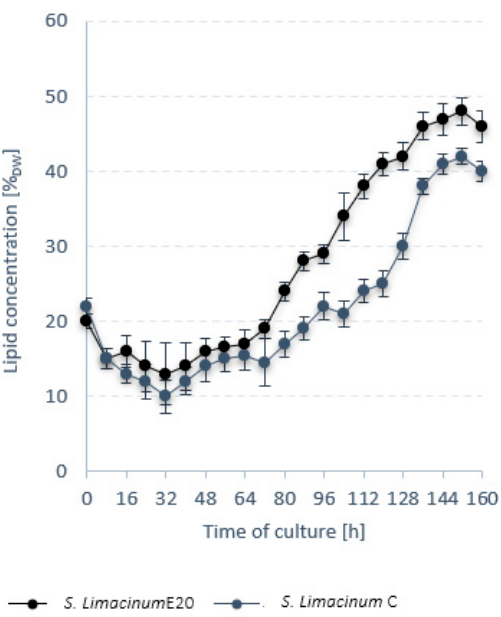
Figure 2. Trends in lipid content of the microalgal